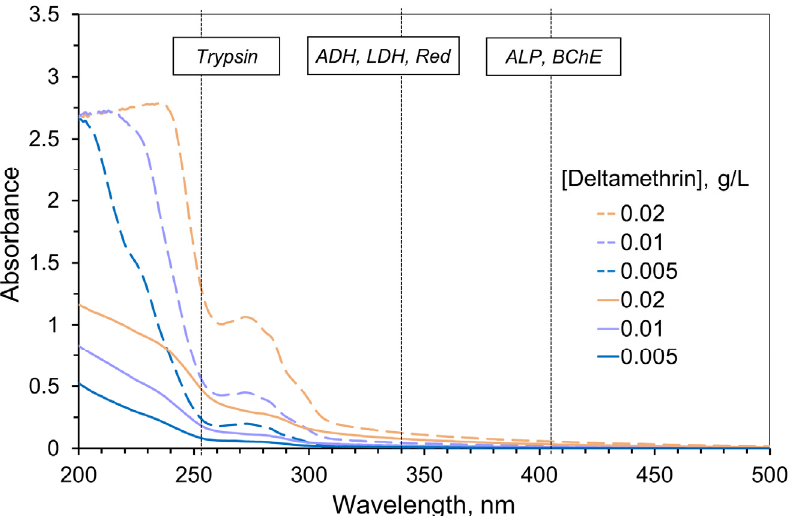
Figure 1. Absorption spectra of the deltamethrin solutions (solid lines) and commercial pesticide formulation Delcid with similar deltamethrin content (dashed lines) obtained with 1 cm optical path length. Acetonitrile was used as the solvent. Vertical dotted lines refer to the wavelengths used for measuring the activity of the enzymes. Bioluminescence intensity was measured in the 400–600 nm range. The absorption of the commercial pesticide formulation demonstrates higher optical density and indicates the need to take into account the inner filter effect when measuring enzyme activities, especially for the assay system with